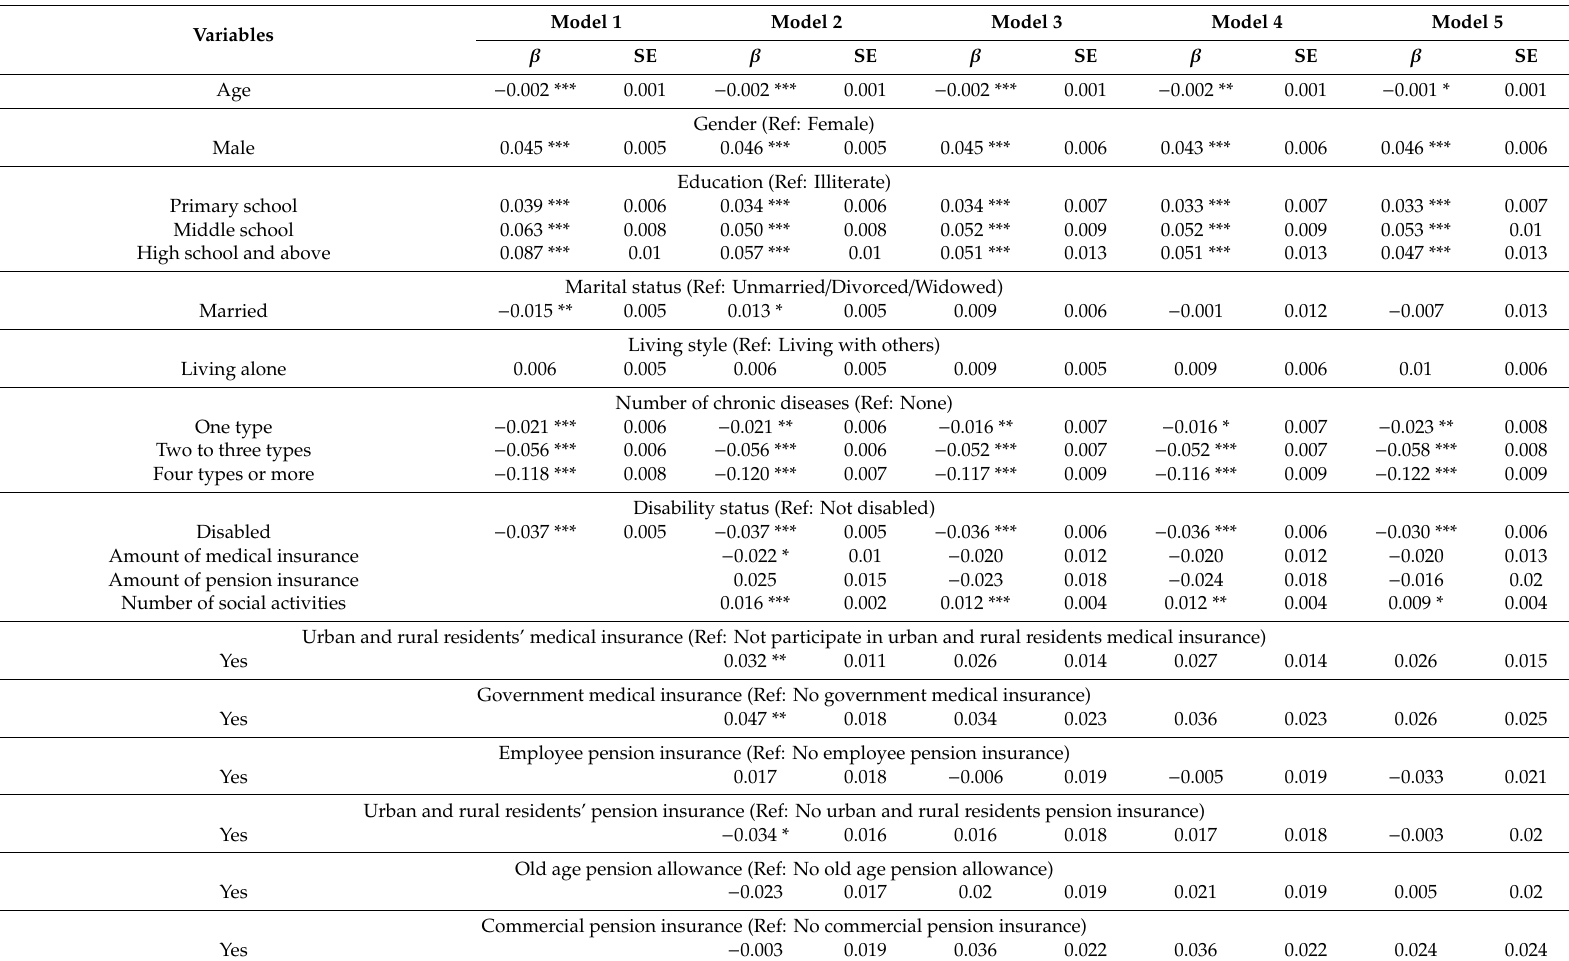
Table 4. Tobit regression analyses of EQ-5D index scores and all social support variables and characteristics